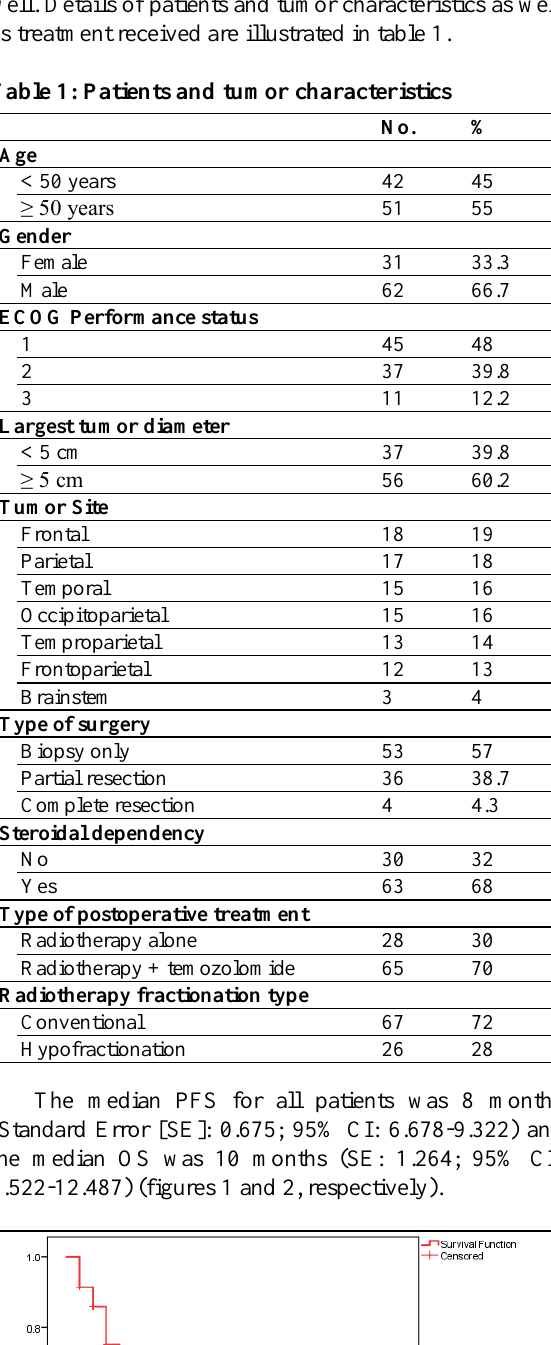
Table 1: Patients and tumor characteristics